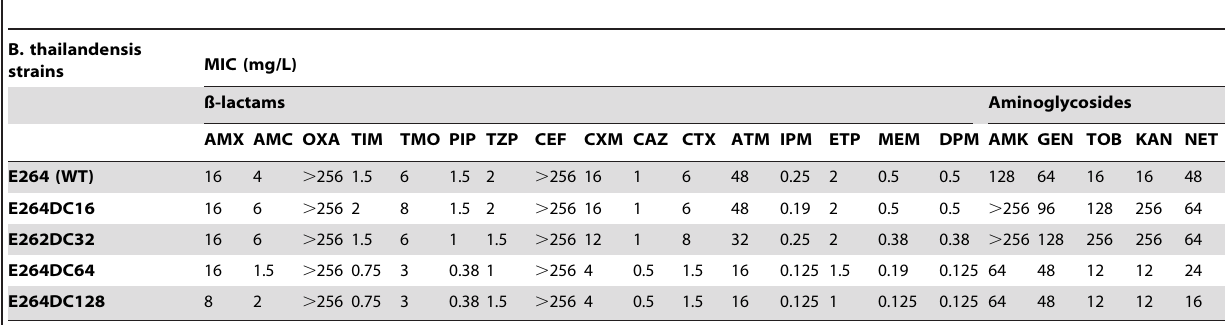
Table 2. Susceptibility of B. thailandensis strains to ß-lactams and aminoglycosides.